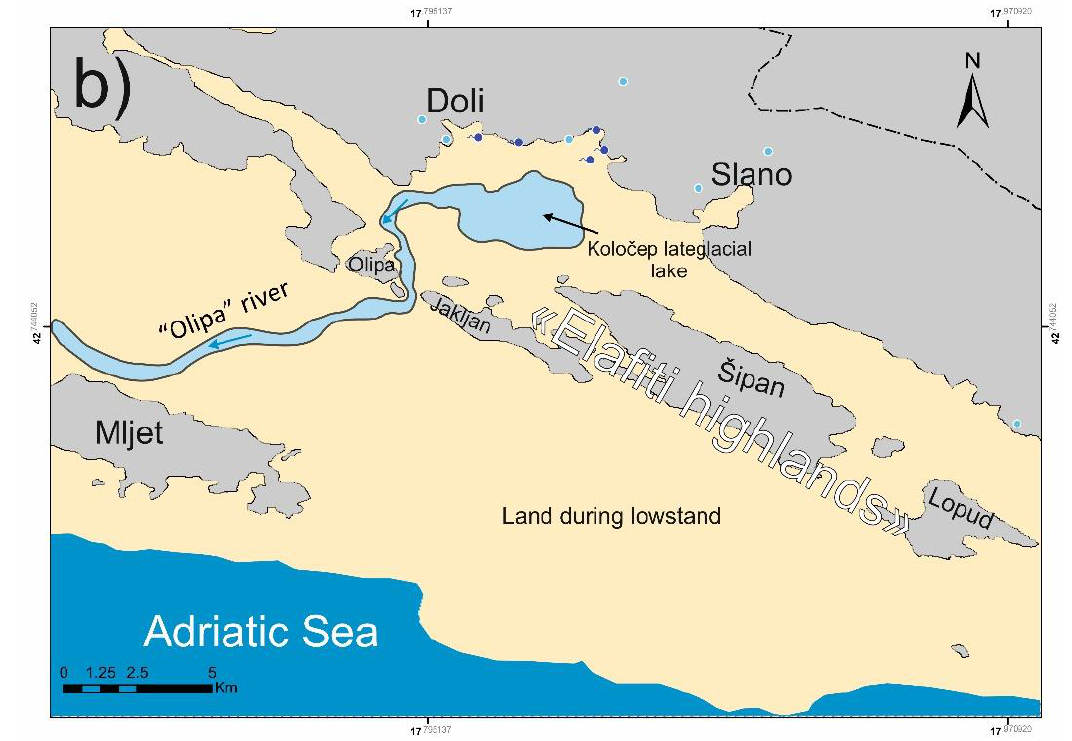
Figure 20. Detailed map from Figure 20 with two possible scenarios of the flow of the Olipa River during lowstand. ( a ) Surface flow of the “Olipa” River through the poljes and submergence in a ponor zone, forming a resurgent stream on the southern side of the carbonate sill with flow towards Mljet Island; ( b ) surface flow of “Olipa” River from the Koločep Late Glacial lake through a river channel between Olipa Island and Jakljan Island with flow towards Mljet Island. Both scenarios imply the formation of a paleochannel in the Pleistocene eolian sand deposits.